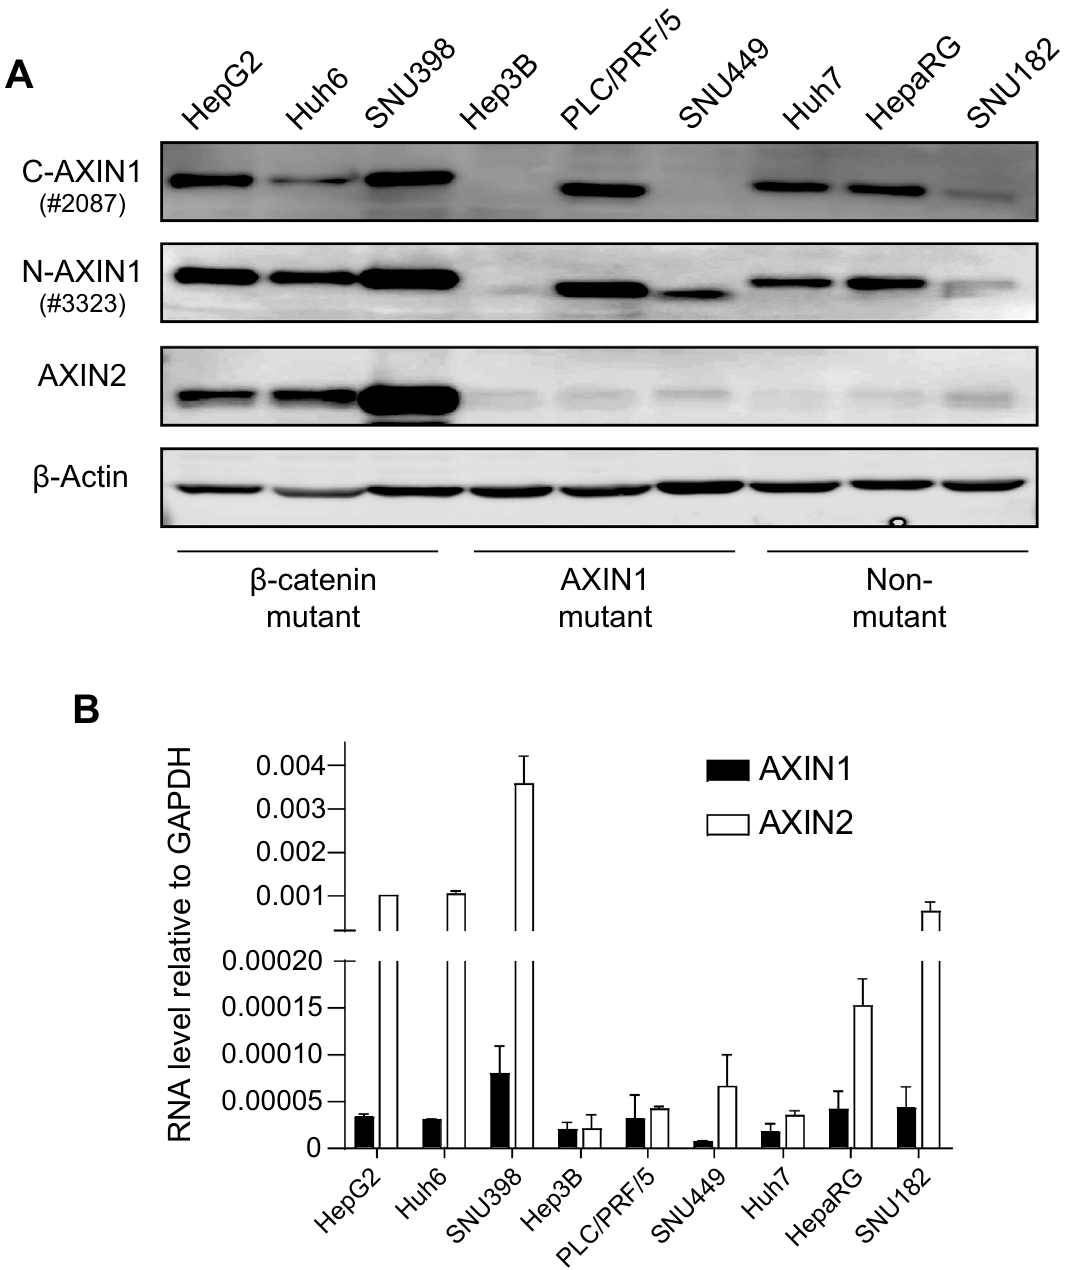
Figure 1. Baseline levels of AXIN1 and AXIN2 in HCC cell lines. ( A ) Western blotting assay showing the basal protein levels of AXIN1 and AXIN2. For AXIN1 both N-terminal and C-terminal antibodies were used, respectively, #3323 and #2087 from Cell Signaling Technology. ( B ) RNA levels tested by TaqMan qRT-PCR (mean ± SD, n = 2, twice). All expression levels are depicted relative to the housekeeping gene GAPDH . Note the interrupted Y-axis